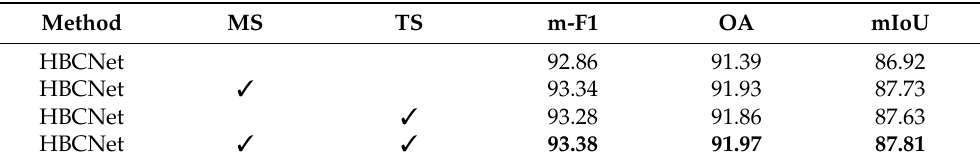
Table 7. Results of different TTA methods for the Potsdam dataset. MS means multi-scale inputs and TS means transpose operations. The values in bold are the best.